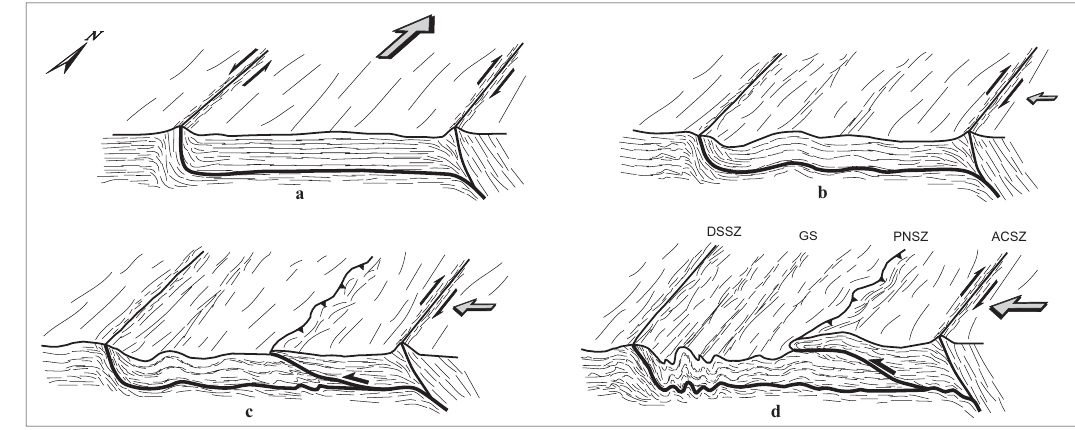
Fig. 11 – Model for the tectonic evolution of the central portion of the studied area, between the Dom Silvério and Abre Campo shear zones during D 1 and D 2